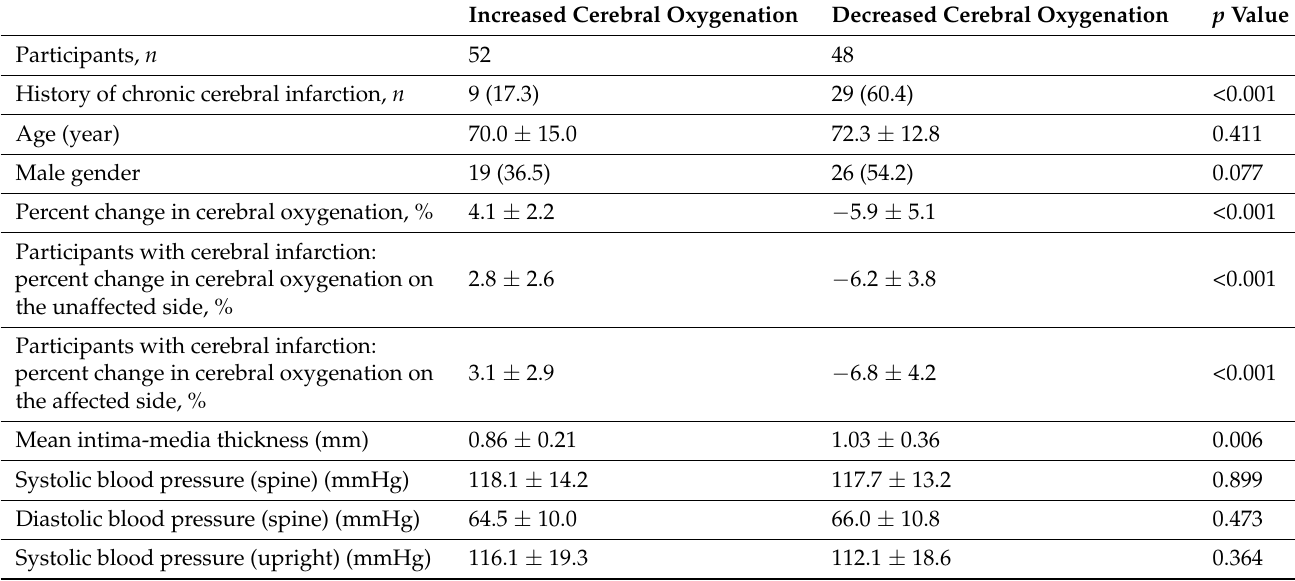
Table 3. Baseline clinical characteristics of the study